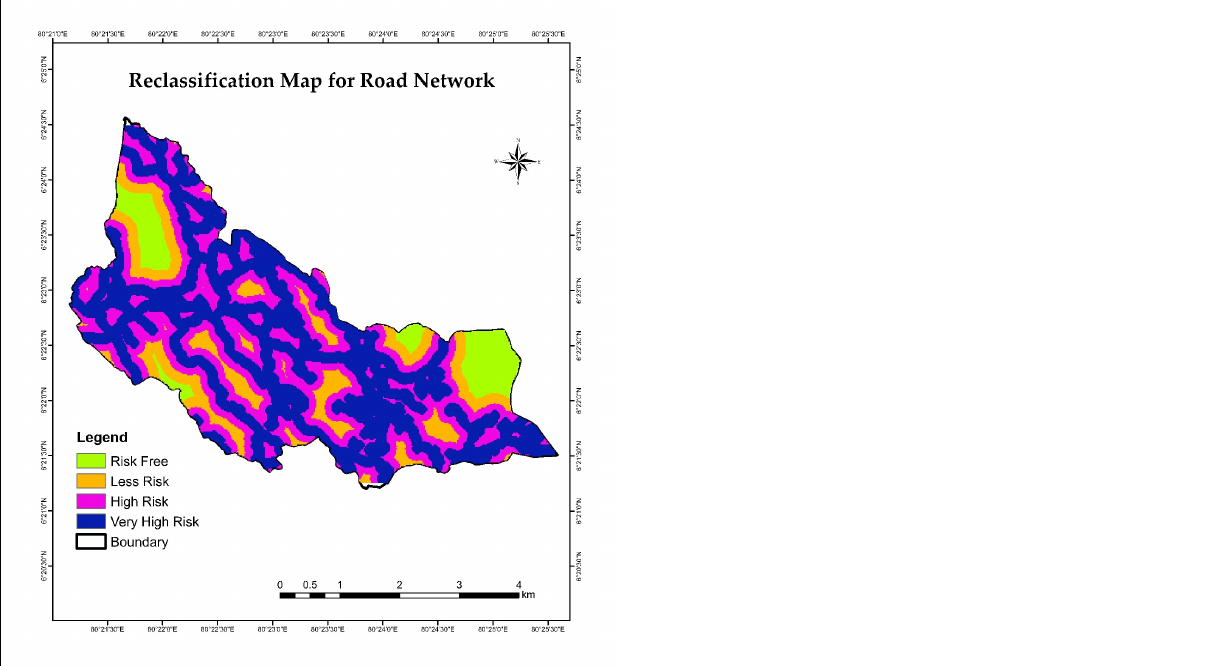
Figure 5. Reclassified Flood Vulnerability potential maps.